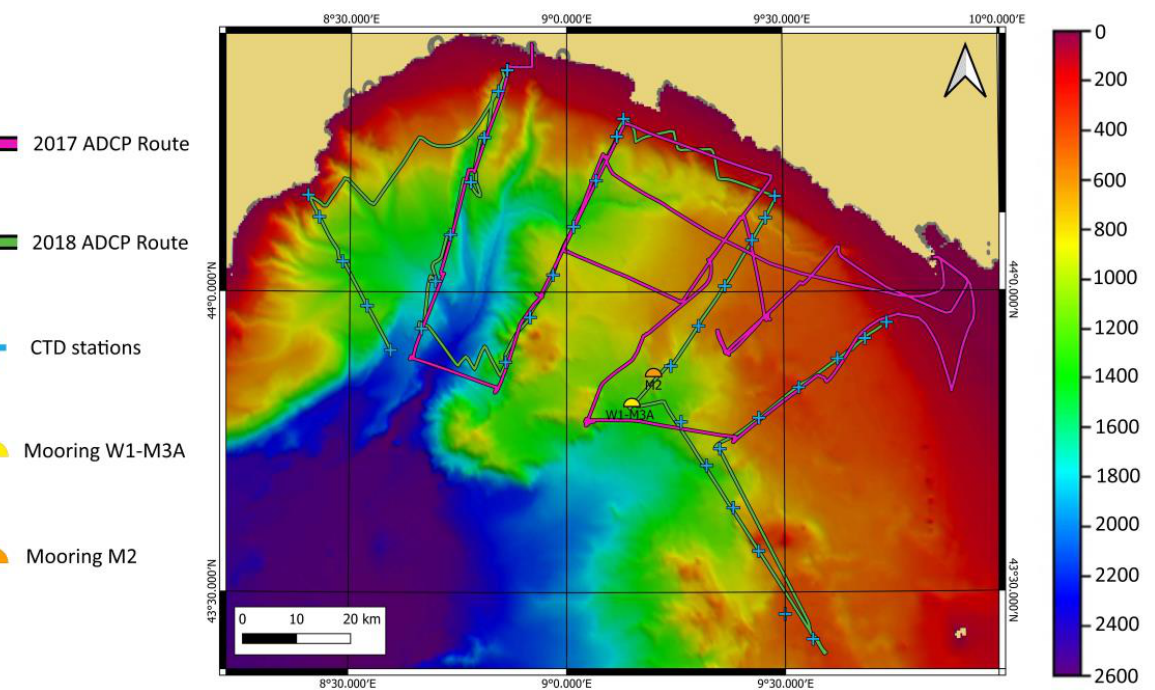
Figure 1. GIS Layer with high resolution bathymetry and representation of available data sources: routes of VM-ADCP measurements, CDT sampling positions and moorings location. Sea depth is given in meters.